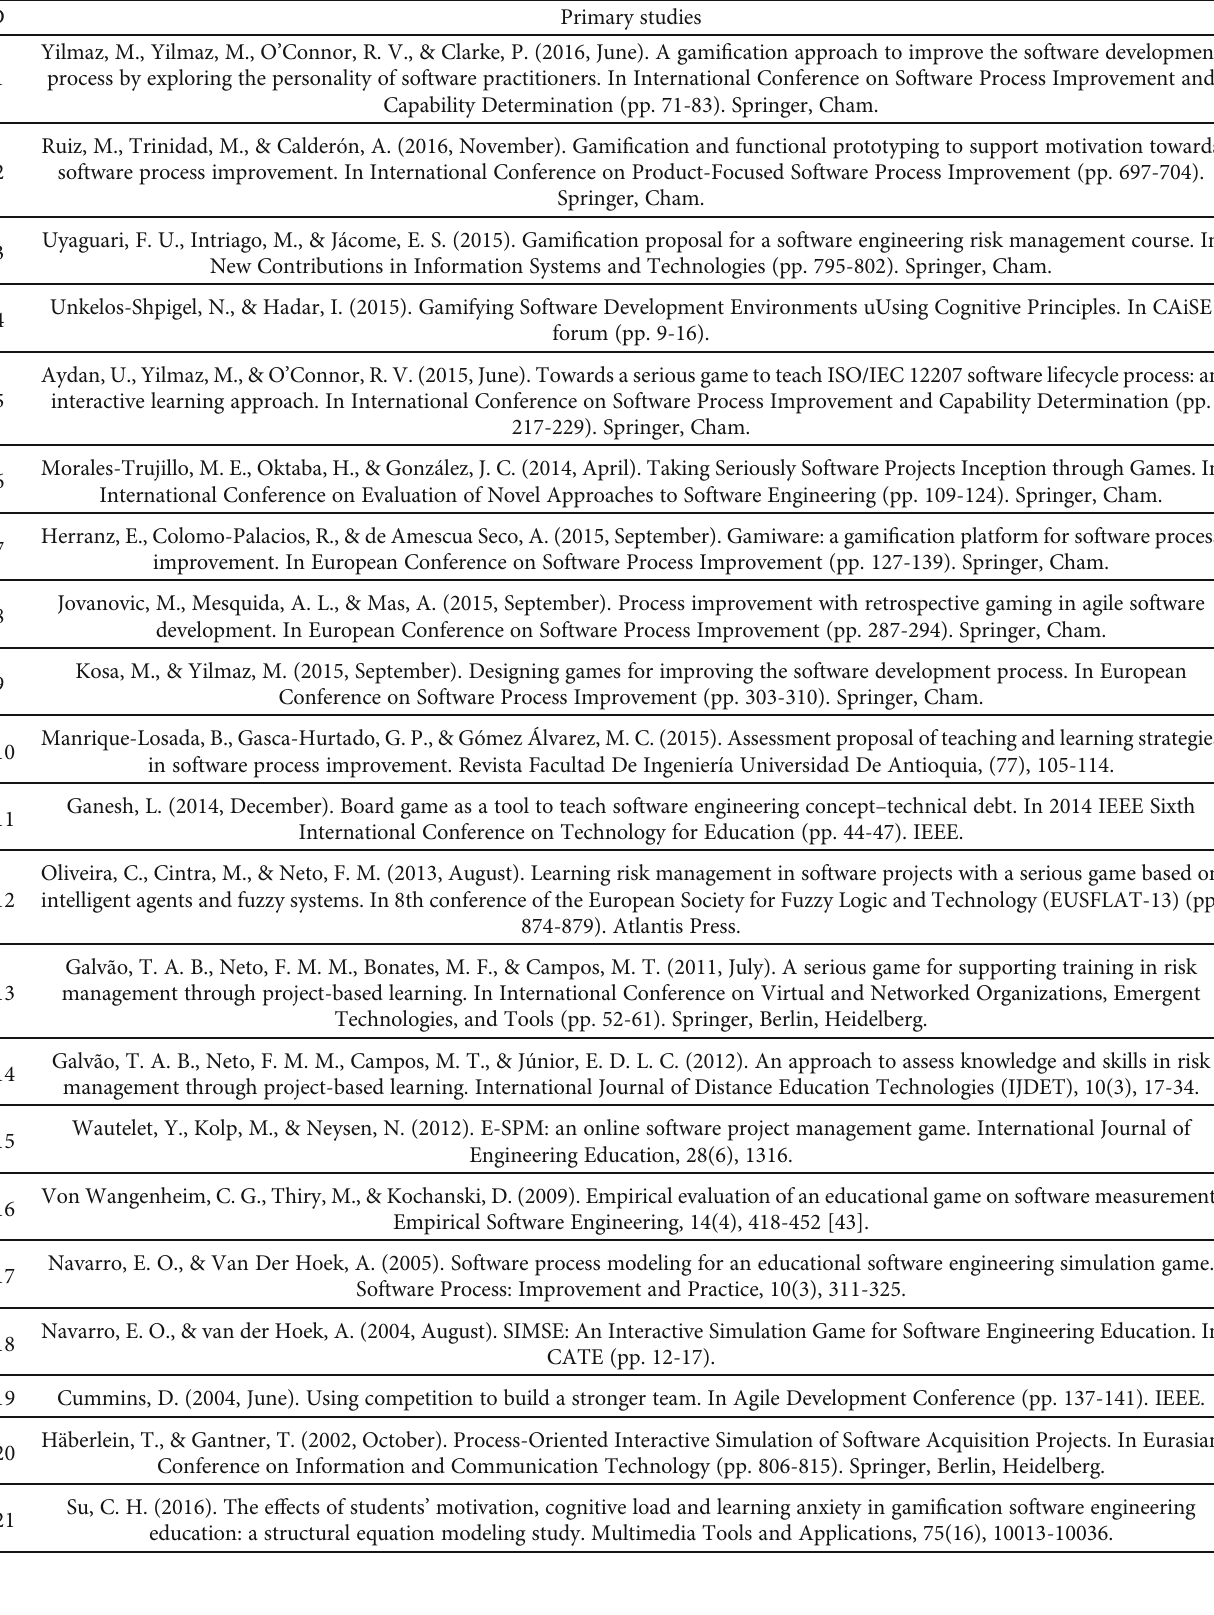
Table 7: Primary papers/articles and their respective code (ID) and